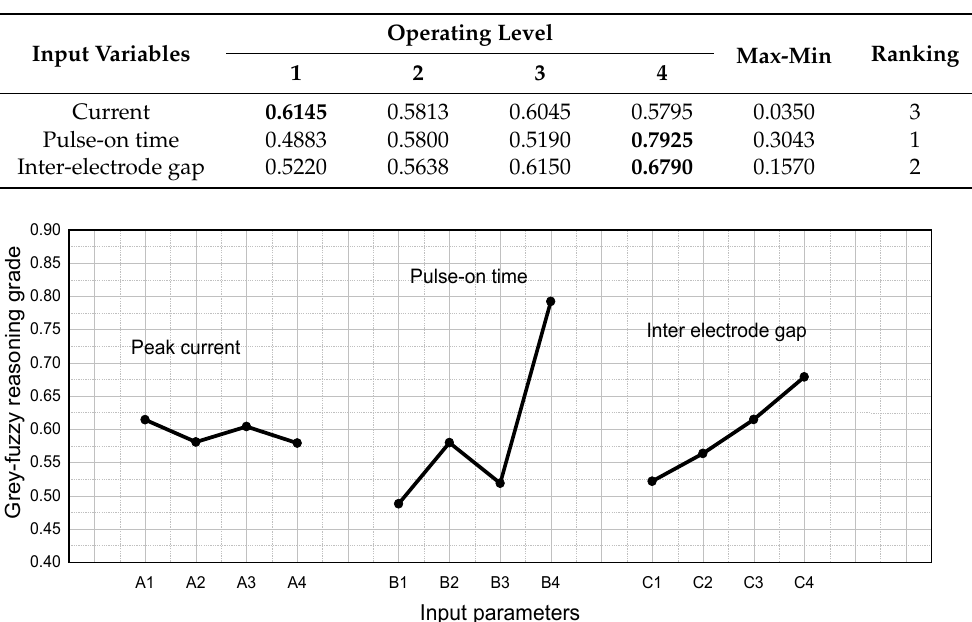
Table 9. Response table obtained for GFRG values. The highest GFRG values for unique machining conditions are shown in bold.